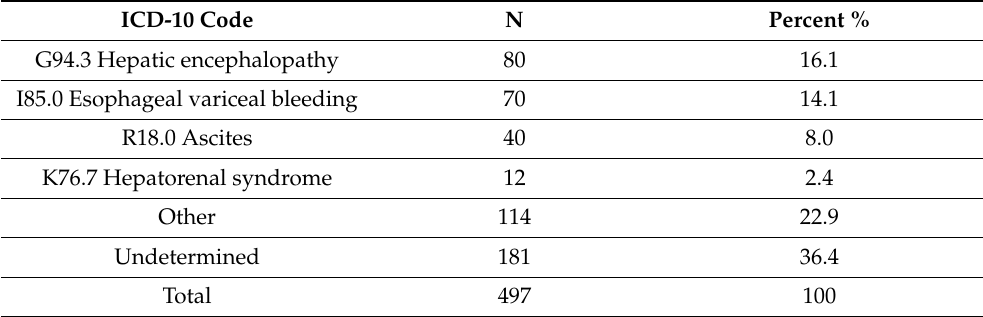
Table 2. Causes of